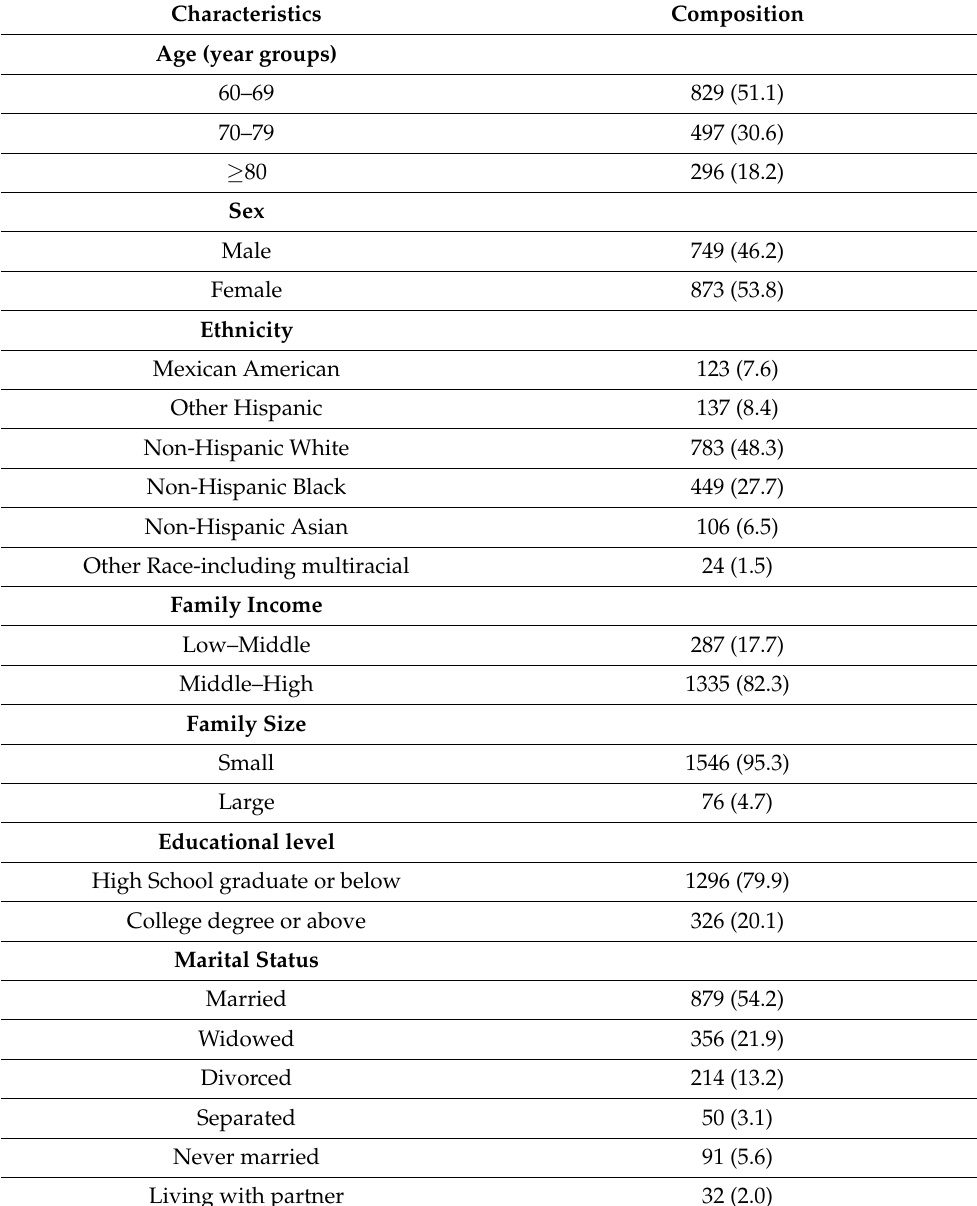
Table 1. Socio-demographic and medical history characteristics of participants ( n = 1622). Values are expressed as count (percentage) unless otherwise